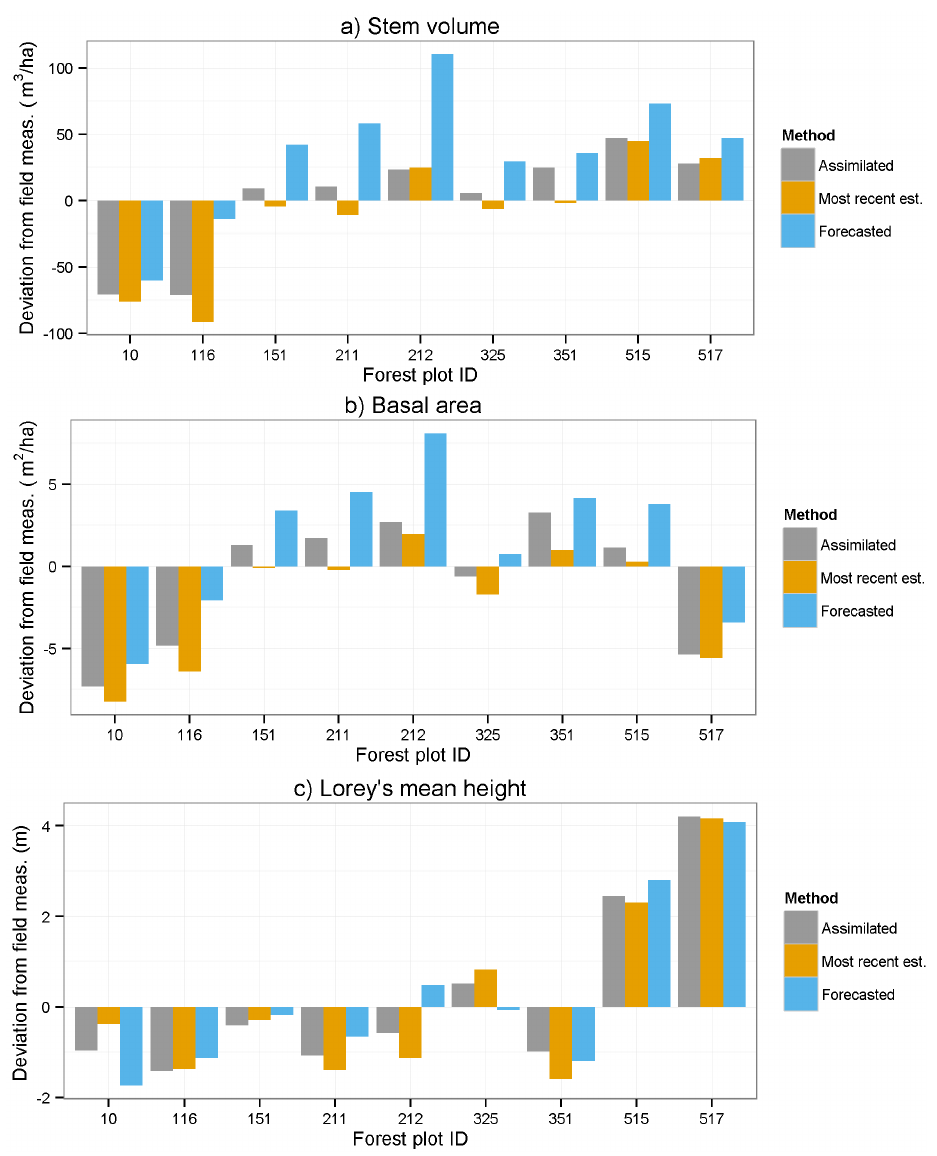
Figure 5. Deviation at year 2011 between field measurement and estimates of ( a ) stem volume; ( b ) basal area, and ( c ) Lorey’s mean height using different methods. A positive value means that the plot has an overestimated value. Table 4. Root mean squared error ( RMSE ) of the deviation from the field measurement 2011 for the nine assimilated plots. In parentheses is relative RMSE .